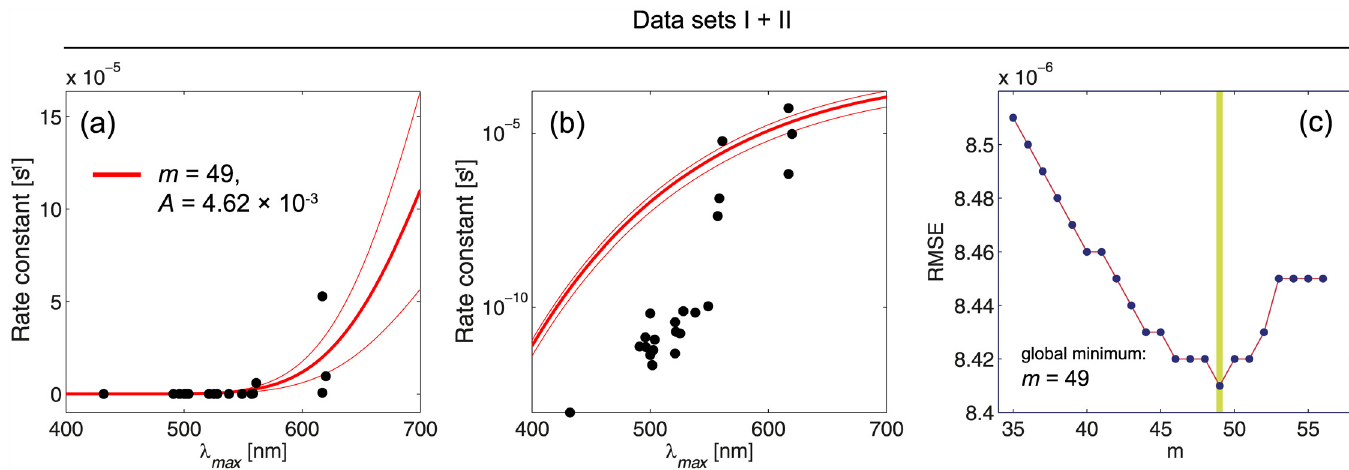
Fig 3. Results of fitting the Eq (7) to the combined data sets (I and II) with linear (a), and logarithmic scaling (b). The RMSE values are obtained for m = 35, 36, ... , 56 (c). The best m and A values for the combination of data sets I, II are obtained, i.e. m = 49 and A = 4.62 × 10 − 3 . The combined data points shows a large amount of discrepancy with the fitted Arrhenius equation based on the Hinshelwood distribution, which indicates that there is no a unique Arrhenius equation based on the Hinshelwood distribution with a unique m value to satisfy the all experimental data.